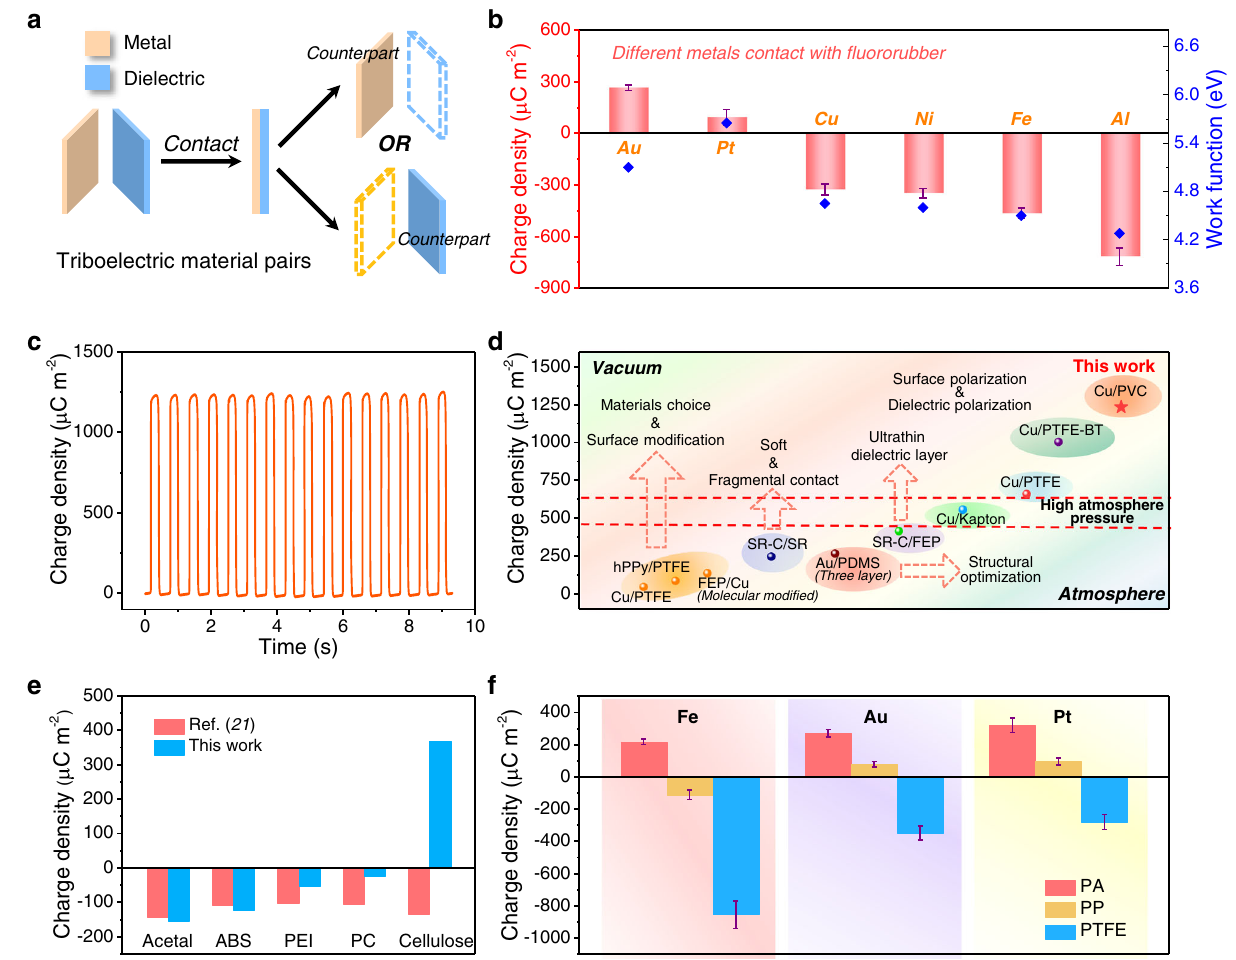
Fig. 4 | Effect of counterpart metal on triboelectric properties of dielectric materials. a Triboelectric material pairs with a metal or a dielectric as the coun- terpart. b TECD of fl uororubber with the counterpart of different metals and their correspondingworkfunctions. c TECDofPVCandCu. d SummaryofTECDrecords and correspondingrealizing methods of the represented works and this work. The corresponding adopted materials is depicted in the circle. e Comparison of the